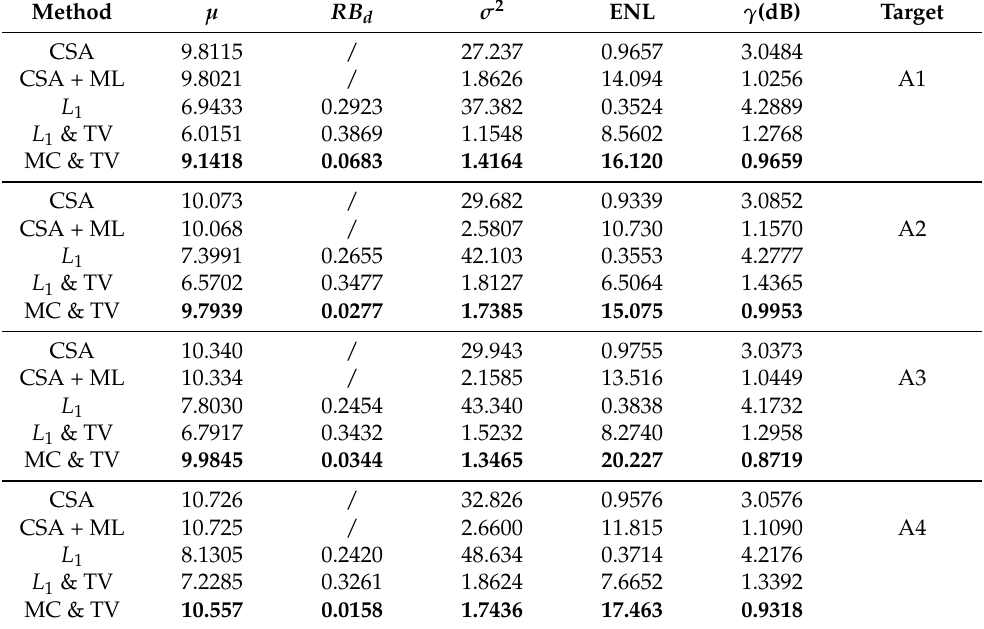
Table 3. The reconstruction accuracy and radiometric resolution of four distributed targets in downsampling experiments based on data 1 for the five methods.